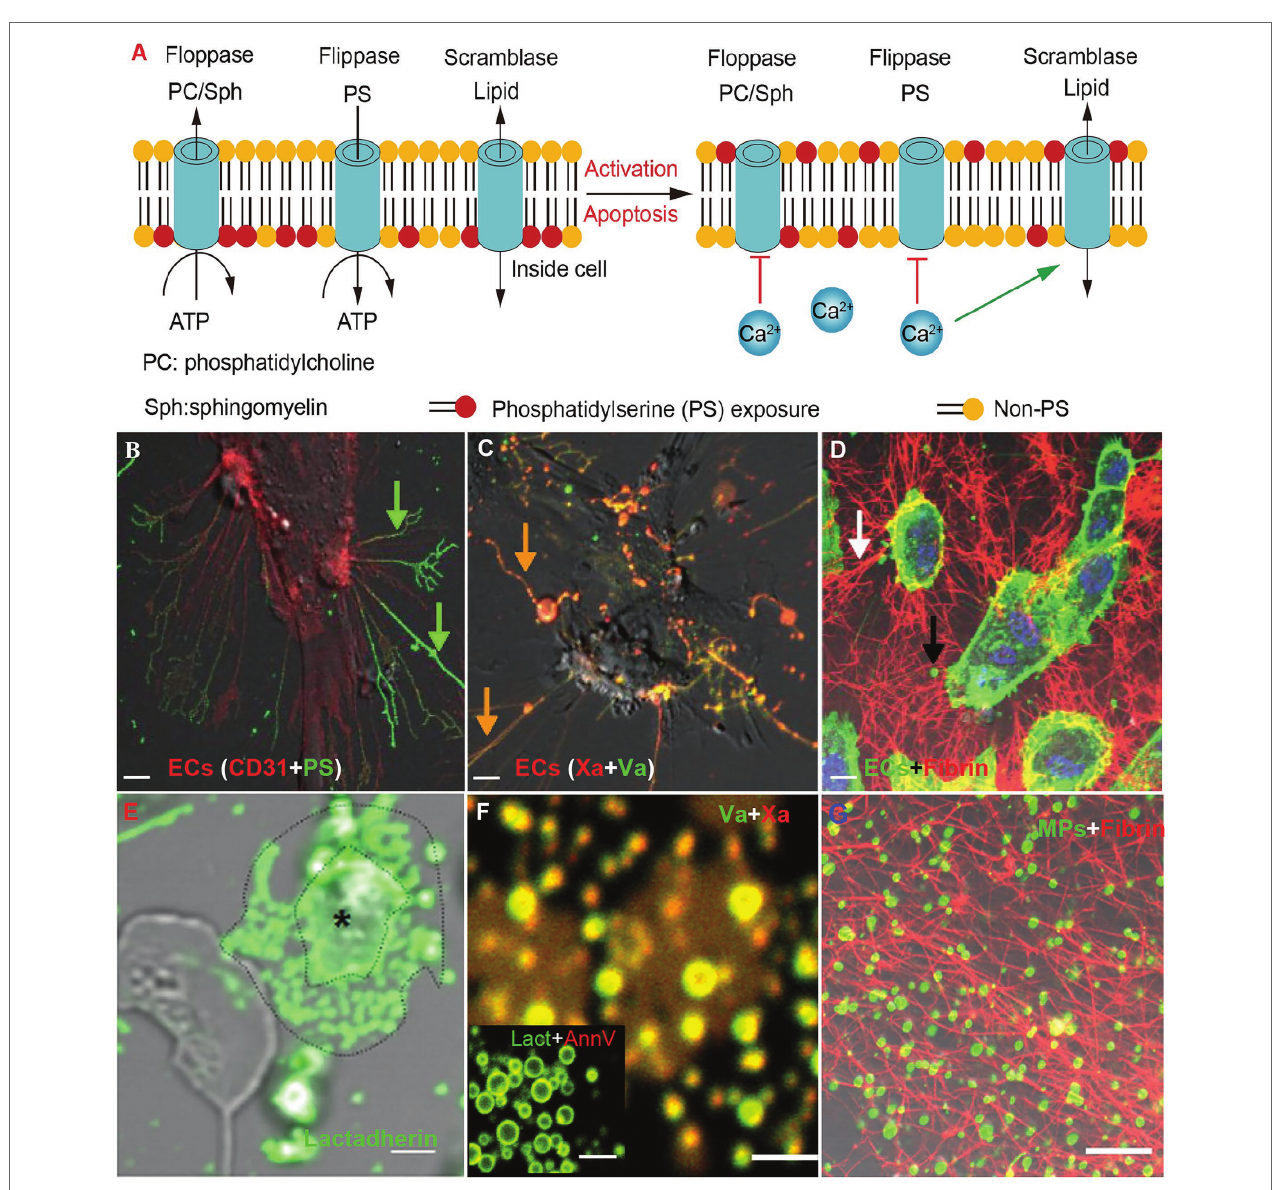
FIGURE 3 | Phosphatidylserine exposure on activated/apoptotic cells and microparticles (MPs) promotes fibrin formation. (A) Phosphatidylserine is usually confined to the inner leaflet of the cell membrane. This asymmetry is maintained through ATP-dependent inward transport of PS by flippases and outward transport of non- PS by floppases (left). Upon stimulation, calcium transients will inhibit ATP-dependent transport and stimulate the nonselective lipid transporter scramblase (ATP- independent), resulting in PS exposure (right). (B–D) Human umbilical vein ECs were treated with healthy human plasma and TNF- ɑ (our previous study; He et al., 2016). (B) ECs retracts the cell margins, extends PS positive filopods and releases endothelial-MPs. (C) The PS + filopods and MPs can be co-stained by Xa and Va. (D) ECs (green) were incubated with MPs-depleted plasma (MDP) in the presence of calcium for 30 min and stained with Alexa Fluro 647-anti-fibrin for 30 min. Considerable fibrin stands among cultured ECs along with filopodia. (E) Confocal images showed PS expression on platelets of patients stained with Alexa 488 lactadherin (our previous study; Ma et al., 2017). MPs from the activated platelet (*) had formed at the margin area located between the distinct outlines. (F) MPs from plasma were co-stained by Xa and Va (or lactadherin and annexin V; our previous study; Gao et al., 2015). (G) MPs that were incubated with recalcified MDP for 30 min and stained with Alexa Fluro 647-anti-fibrin for 30 min. Converted fibrin networks were detected around MPs. The inset bars represent 5 μ m in (B–D,G) and 2 μ m in (E,F)